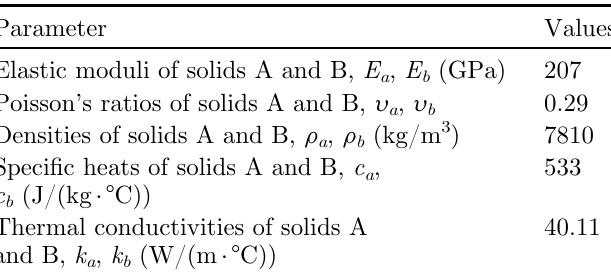
Table 1. Properties of contact solids A and